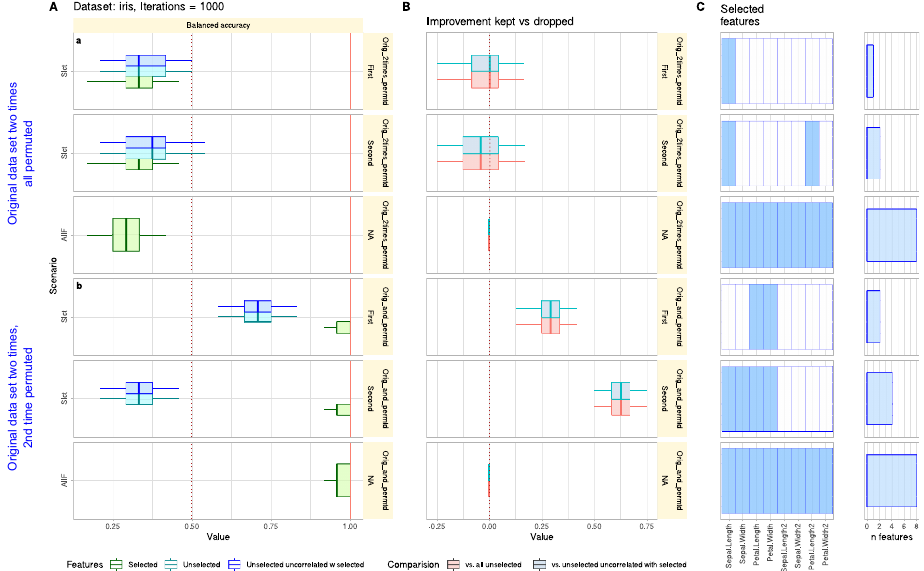
Figure 3. Feature selection and classification performance evaluation with different feature sets in the iris data set [28]. The graph is divided into subgraphs a - b from top to bottom. Experiments were performed ( a ) with doubling each variable and randomly permuting all variables, ( b ) doubling the data set and randomly permuting the second version of each variable while leaving the first versions in their original stage. Each subgraph is organized in three further subgraphs, showing from top to bottom (i) the results when using the features selected in the default feature selection, (ii) the features added when performing a second feature selection on the unselected features from the first selection, and (iii) when training the algorithm with the full feature set. The boxes show the 25th, 50th (blue vertical line), and 75th percentiles of balanced accuracies obtained in 1000 repeated runs with a random selection of 67% from the training data set and 80% from a validation data set separated from the data set before feature selection. Whiskers span the 95% confidence interval from the 2.5th to the 97.5th percentiles. ( A ): Balanced accuracy obtained with a random forests classifier trained with (i) the selected features, (ii) the unselected features, and (iii) the unselected features that were not highly correlated with the selected features, with the correlation threshold set at a very strong correlation of ρ > 0.9. ( B ): Difference in balanced accuracy when algorithms were trained with the selected versus unselected features. ( C ): Selected features (blue) and unselected features